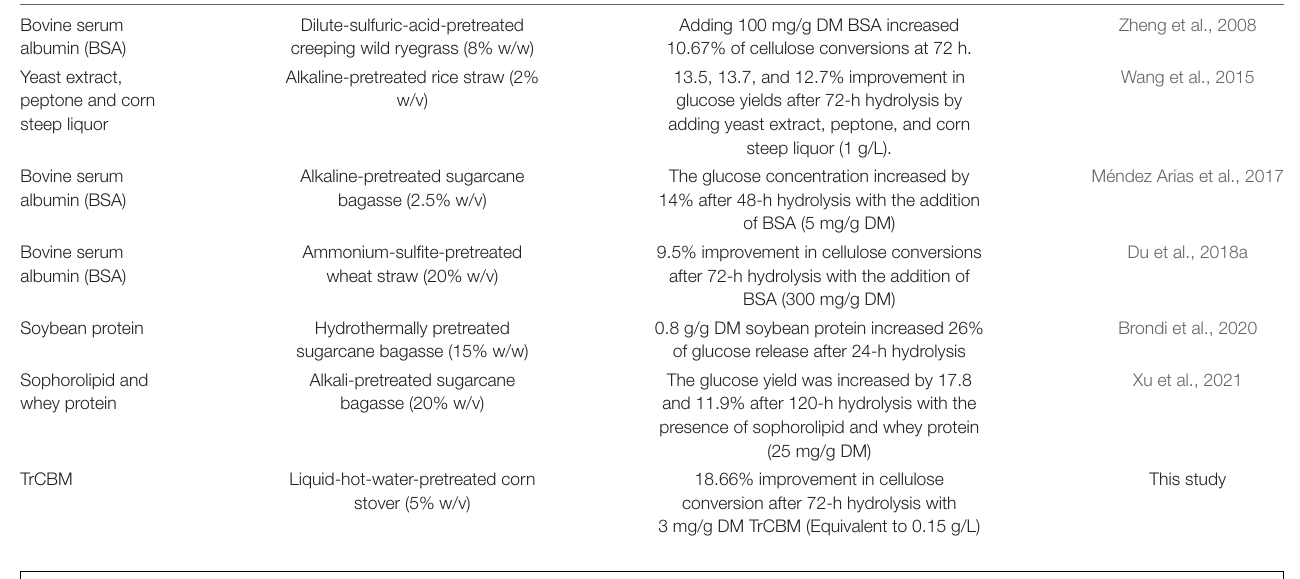
TABLE 1 | Enhancement efficiency of some reported accessory proteins on enzymatic hydrolysis of lignocellulose. Additives Substrate